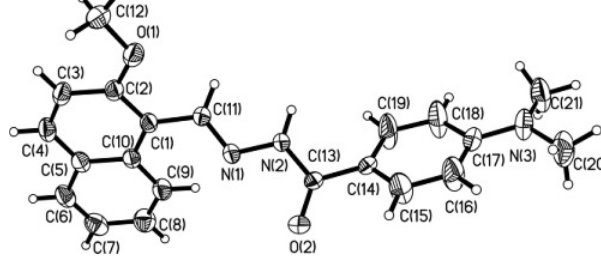
Table 2. Atomic coordinates and displacement parameters (in Å 2 )